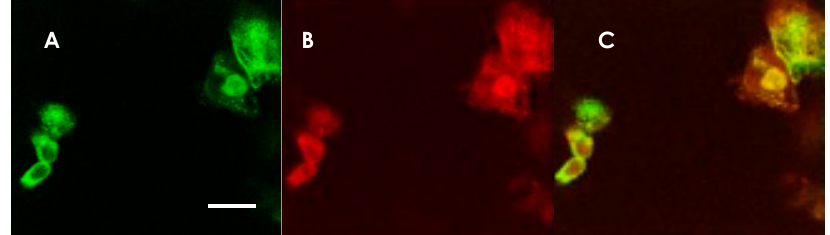
Figure 1. Anti-NMDAR antibody-detection using NMDAR GluN1 and GluN2B co-transfected HEK 293 cells. Immunostaining of HEK 293 cells expressing NMDARs in a patient’s CSF and a mixture of rabbit anti-NMDAR antibodies. The same cells were doubly stained with a patient’s CSF and a mixture of rabbit anti-GluN1 and anti-GluN2B antibodies. A ) Staining with CSF from an anti-NMDAR encephalitis patient. AlexaFluor 488-conjugated anti human IgG was used for the secondary antibody (green). B ) Staining with rabbit anti-GluN1 and anti-GluN2B antibody mixture. AlexaFluor 594-conjugated secondary antibody was used (red). C ) Superimposition of the two micrographic images, indicating that the CSF was positive in the anti-NMDAR antibodies. The scale bar in A (10 μ m) applies also to B and C.